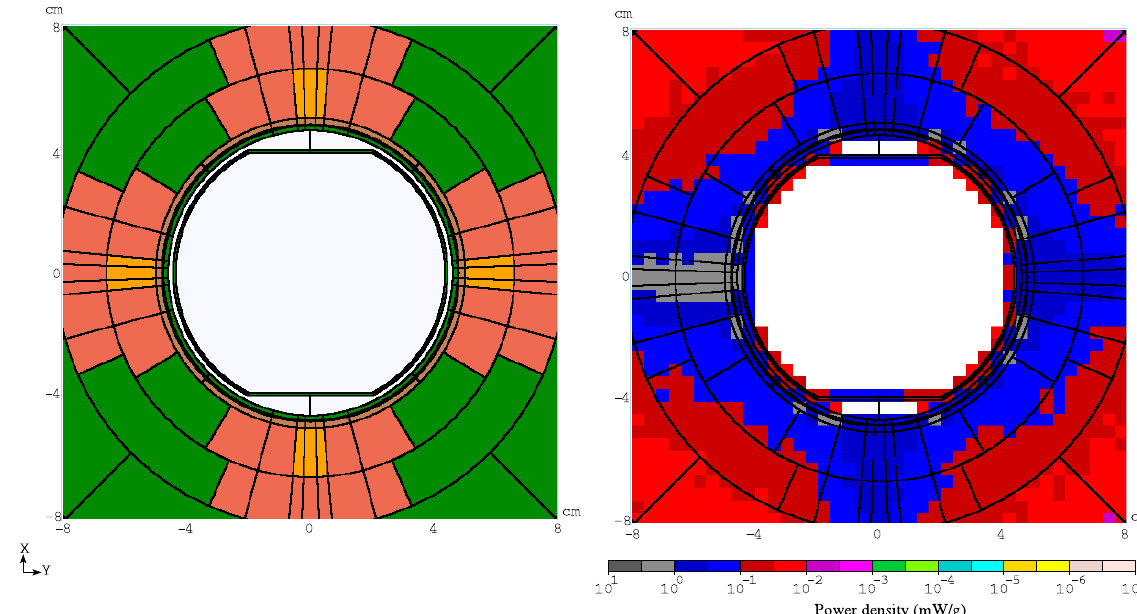
FIG. 7. (Color) A cross section of the geometry model of a 100-mm Q2B quadrupole with spacers shown with brown color (left) and corresponding power density distribution around Z (cid:5) 42 m calculated with aluminum spacers (right).